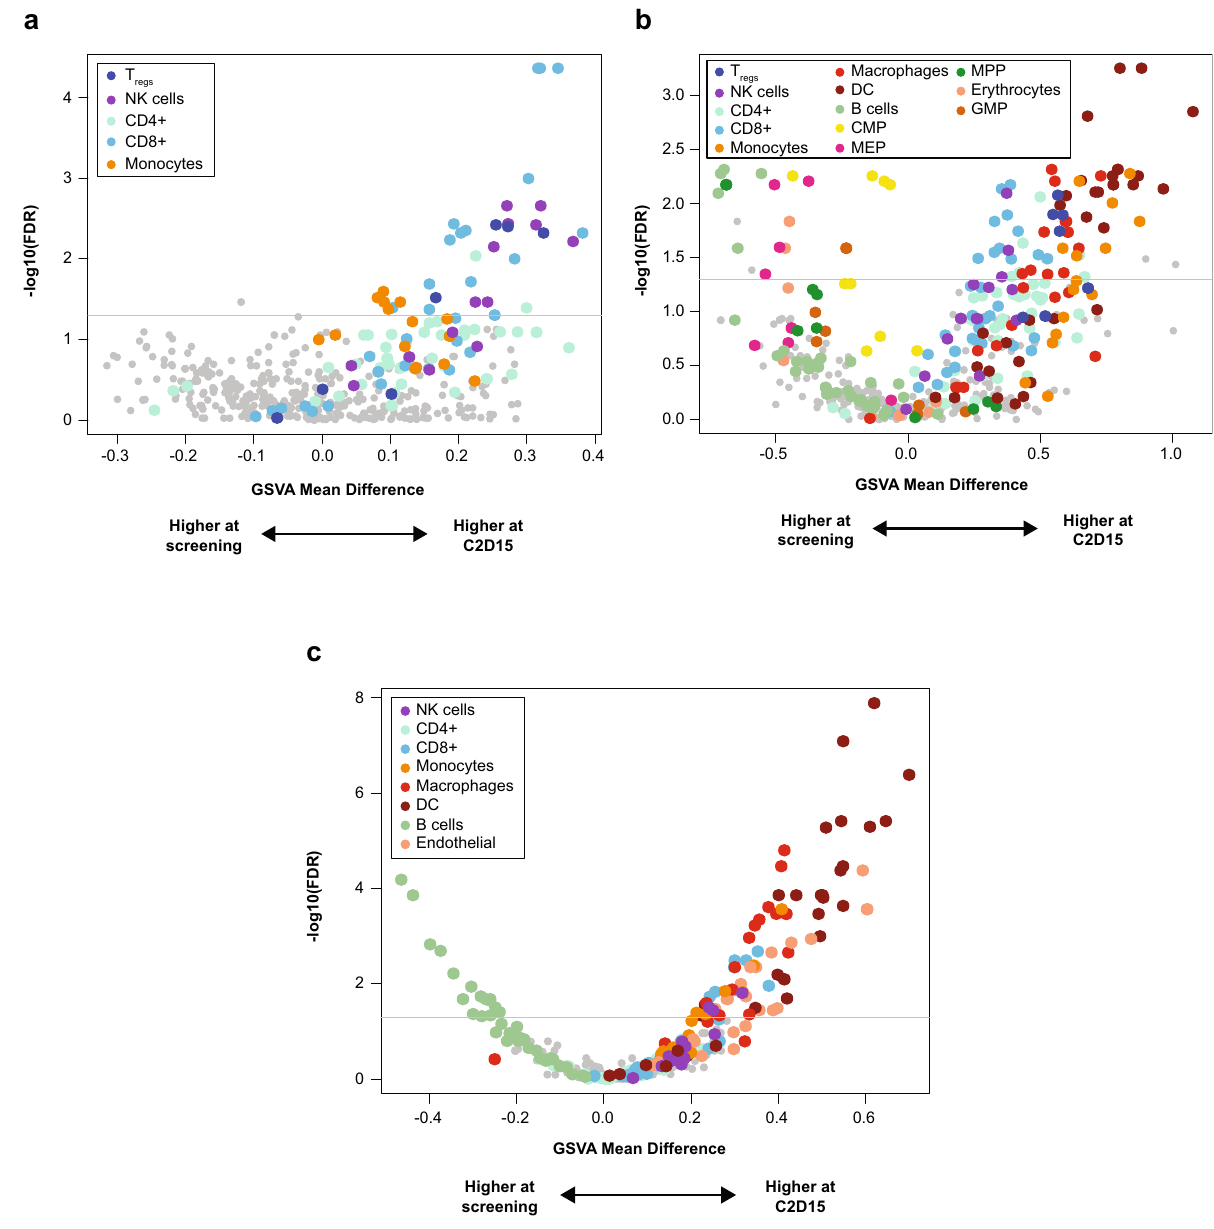
Figure 3. Estimation of immune cell populations based on RNA sequencing data using the gene set enrichment analysis using gene sets from xCell 27 at screening and cycle 2 day 15 (C2D15) treated with: ( a ) durvalumab monotherapy (screening n = 15; C2D15 n = 7); ( b ) durvalumab + pomalidomide (screening n = 6; C2D15 n = 2); ( c ) durvalumab + pomalidomide + dexamethasone (screening n = 53; C2D15 n = 50). The y-axis is the negative log 10 of the P